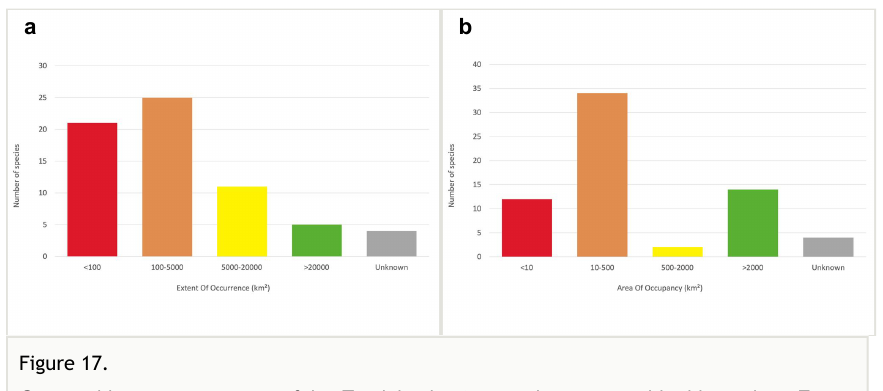
Geographic range measures of the Troglohyphantes species assessed in this study: a Extent Of Occurrence (EOO) and b Area Of Occupancy (AOO).